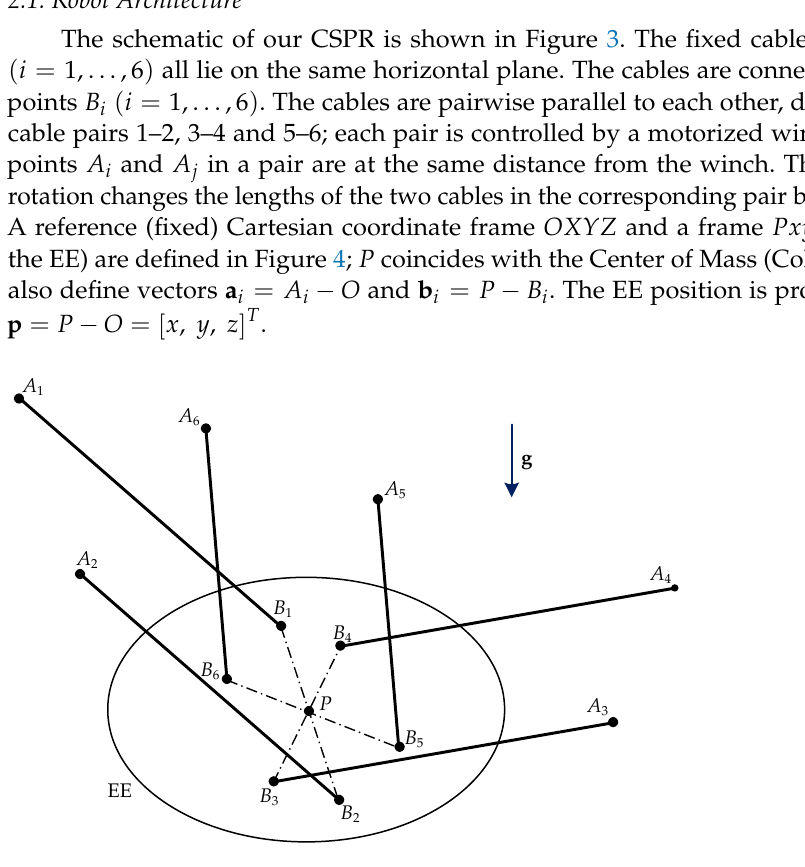
Figure 3. Schematic of a spatial, six-cable CSPR with parallelogram actuation; P is the CoM of the